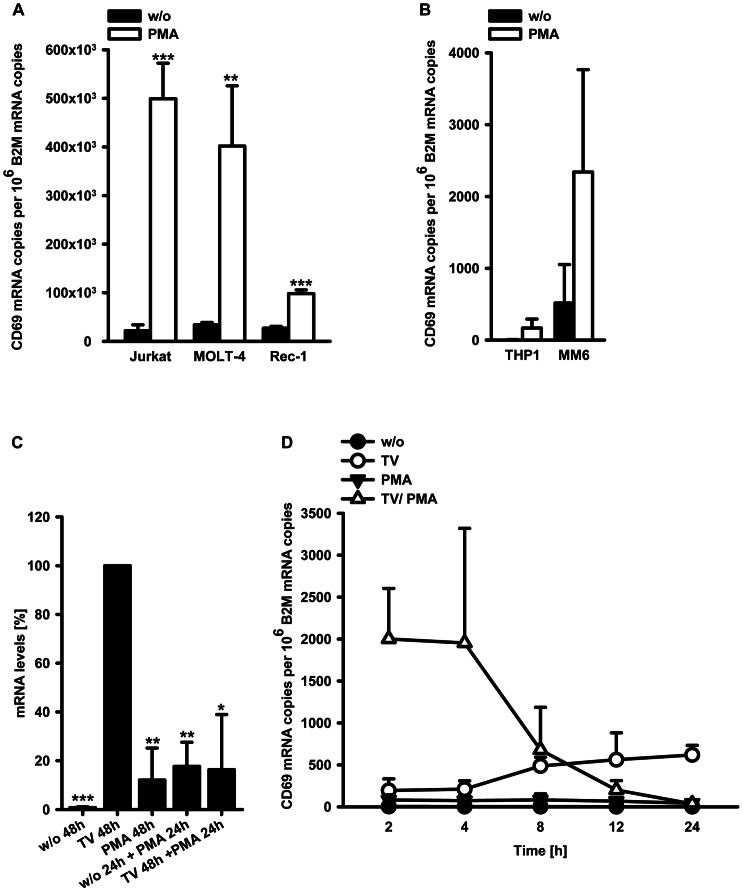
Influence of PMA on CD69 mRNA levels in dependence of time and cotreatment.(A and B) Cells were treated with (PMA) or without (w/o) 20 ng/ml PMA for 24 h. Subsequently, mRNA levels were determined by qPCR. Statistical analysis of (A) and (B) was conducted with unpaired, two-tailed t-test (**P<0.01; ***P<0.001). (C) THP-1 were treated with 1 ng/ml TGF-β and 50 nM 1α,25(OH)2D3 (TV), 20 ng/ml PMA (PMA) or left untreteated as control (w/o) for 48 h. Alternatively, cells were pretreated with (TV) or without (w/o) 1 ng/ml TGF-β and 50 nM 1α,25(OH)2D3 for 24 h and 20 ng/ml PMA was added for further 24 h. Subsequently, CD69 mRNA levels were determined by qPCR. The CD69 mRNA level of cells treated with TGF-β/1α,25(OH)2D3 for 48 h was set to 100. Statistical analysis was conducted with one sample t-test (*P<0.05; **P<0.01; ***P<0.001). (D) THP-1 were incubated with 1 ng/ml TGF-β and 50 nM 1α,25(OH)2D3 (TV), 20 ng/ml PMA (PMA), all three agents together (TV/PMA) or left untreated as control (w/o) for the indicated times. Subsequently, CD69 mRNA levels were determined by qPCR.